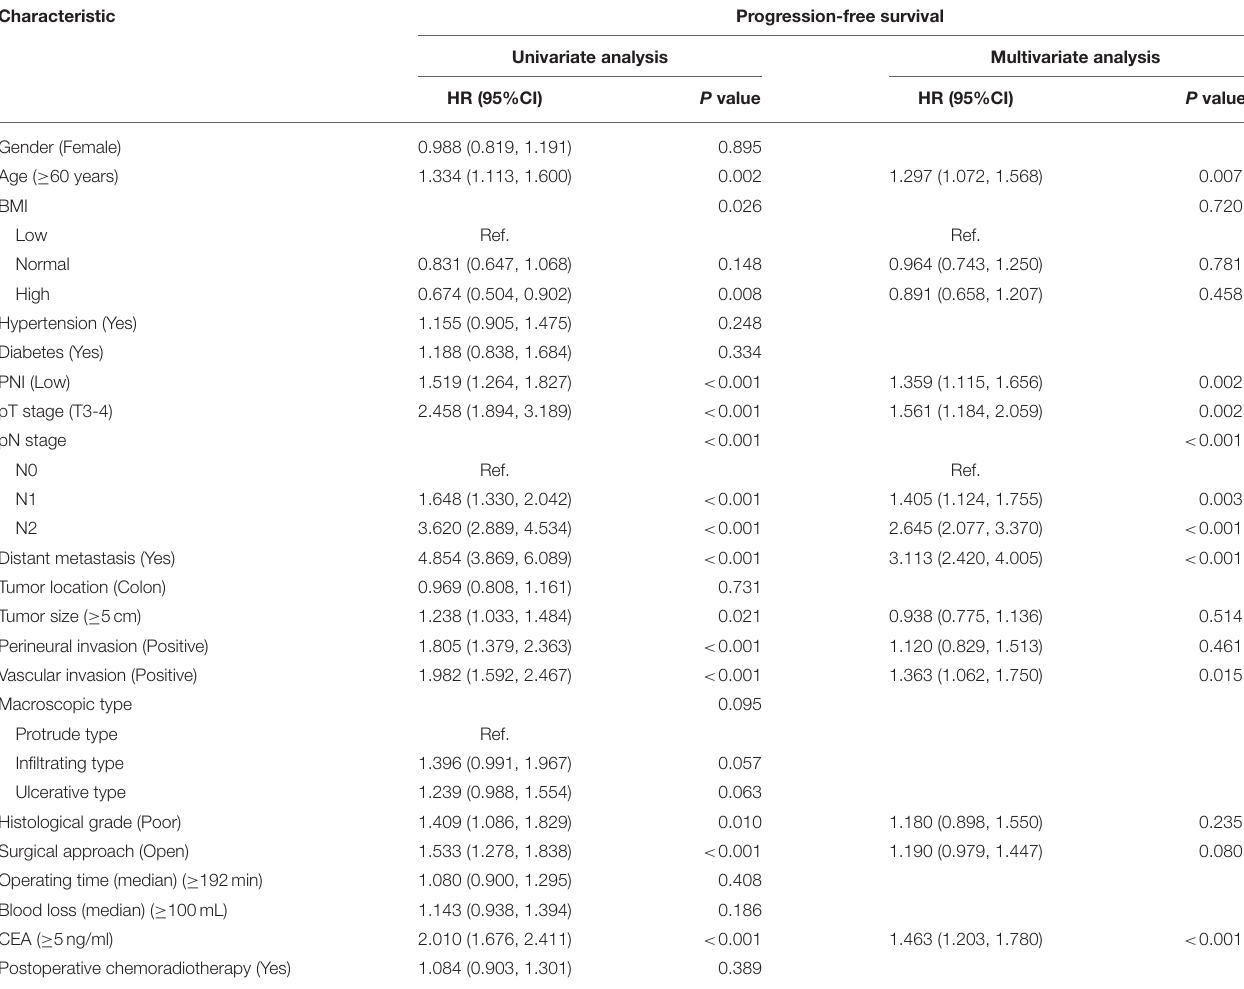
TABLE 2 | Univariate and multivariate Cox regression analysis of clinicopathological characteristics associated with progression-free survival. Characteristic Progression-free survival Univariate analysis Multivariate analysis